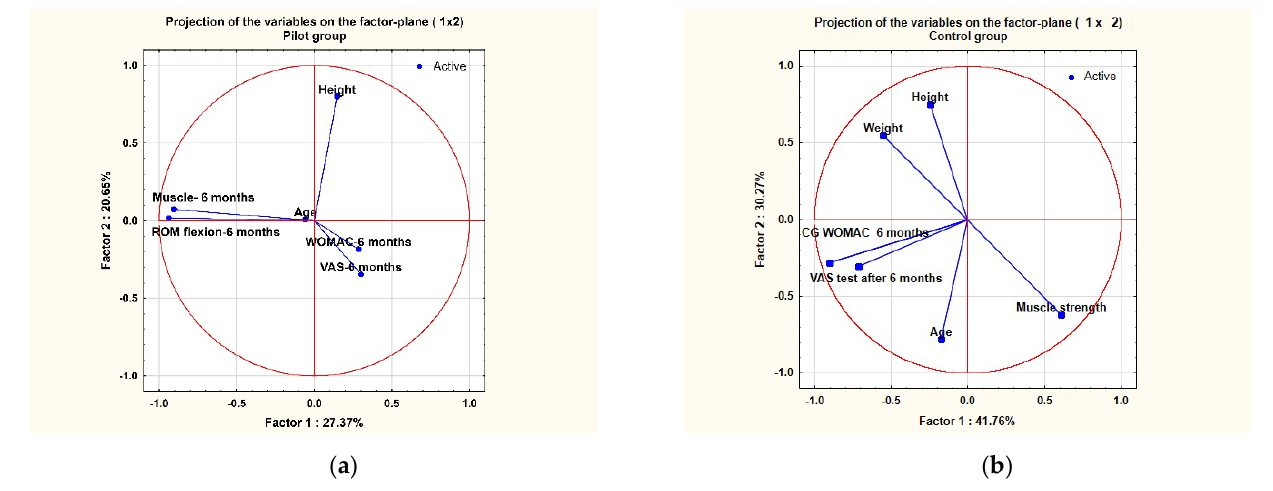
Figure 12. PCA analysis results for the ( a ) pilot group and ( b ) control group at 6 months. Table 12. Factor coordinates of the variables based on correlations for the pilot group (PG) after 6 months.